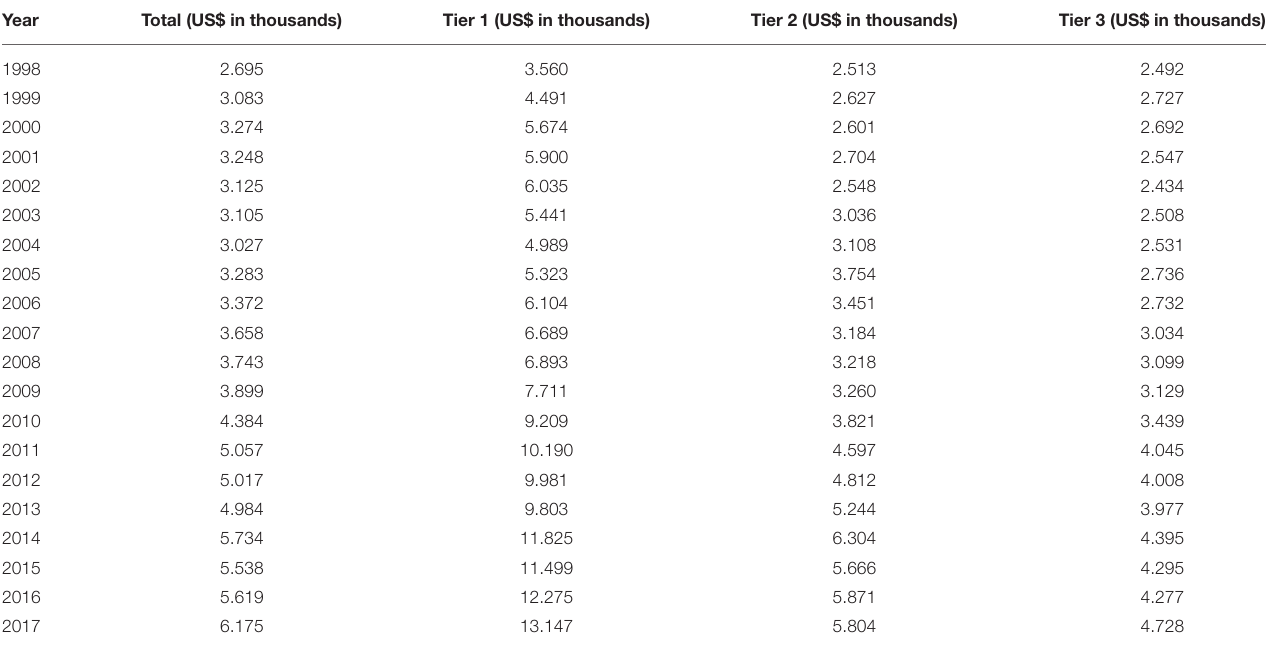
TABLE 2 | Average funding per student by tiers of health professional institutions: 1998–2017.